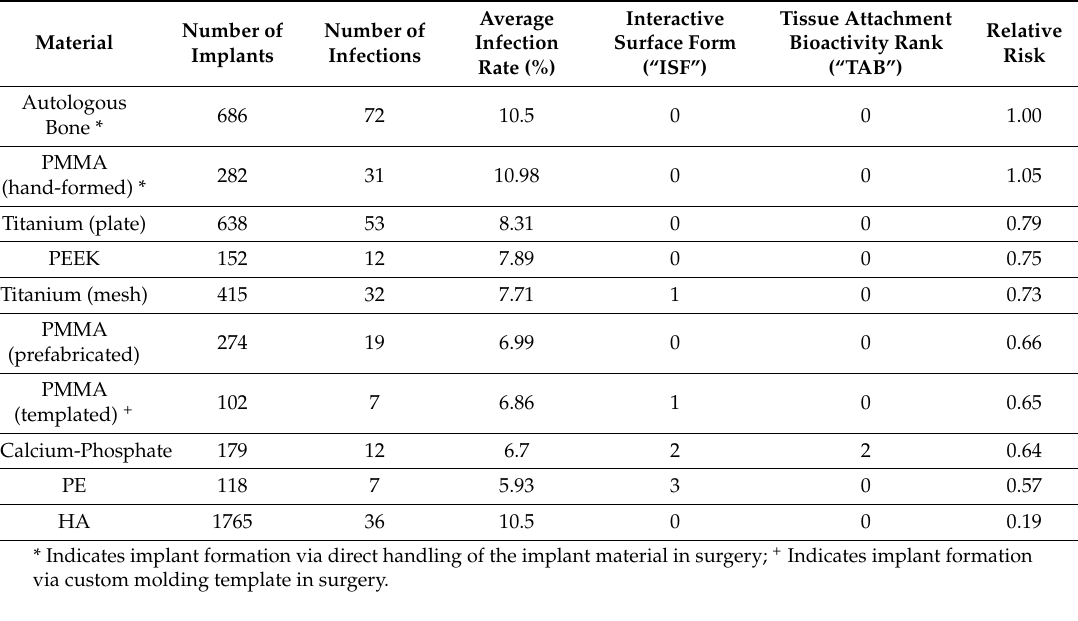
Table 10. Cranioplasty/craniofacial implant material: comparison of associated infection risk, surface form and tissue attachment.